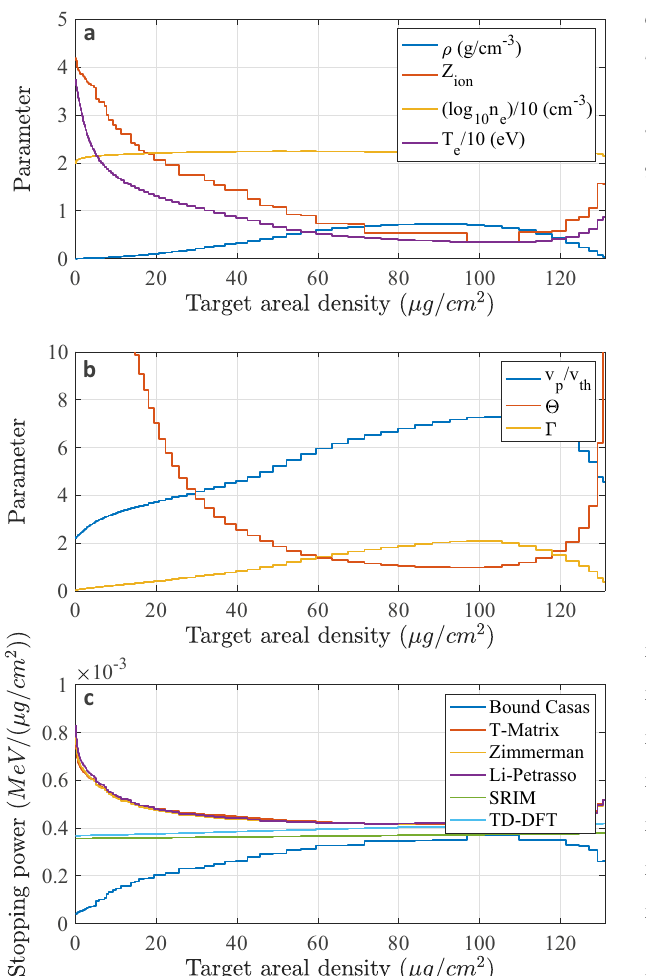
Fig. 9 Plasma conditions and stopping power along the plasma central axis at a time t = 50 ps. a Mass-density, electron temperature, free electron density and mean ionization degree. b Electron coupling Γ , electron degeneracy Θ and velocity ratio v p / v th for a 500 keV energy proton. c Corresponding stopping-power pro fi les. The bound-electron contribution as well as the stopping power in the solid target according to the SRIM database are also represented. The x -axis is reported in areal-density